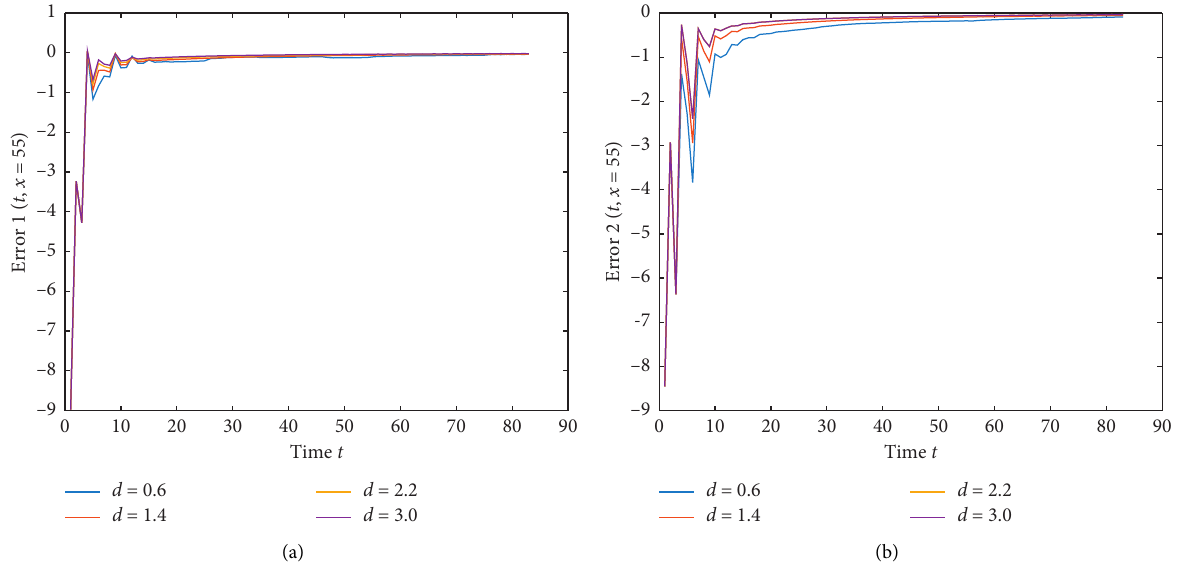
Figure 4: Trajectories of error system (26) at spatial position x � 55 under different diffusion coefficients.